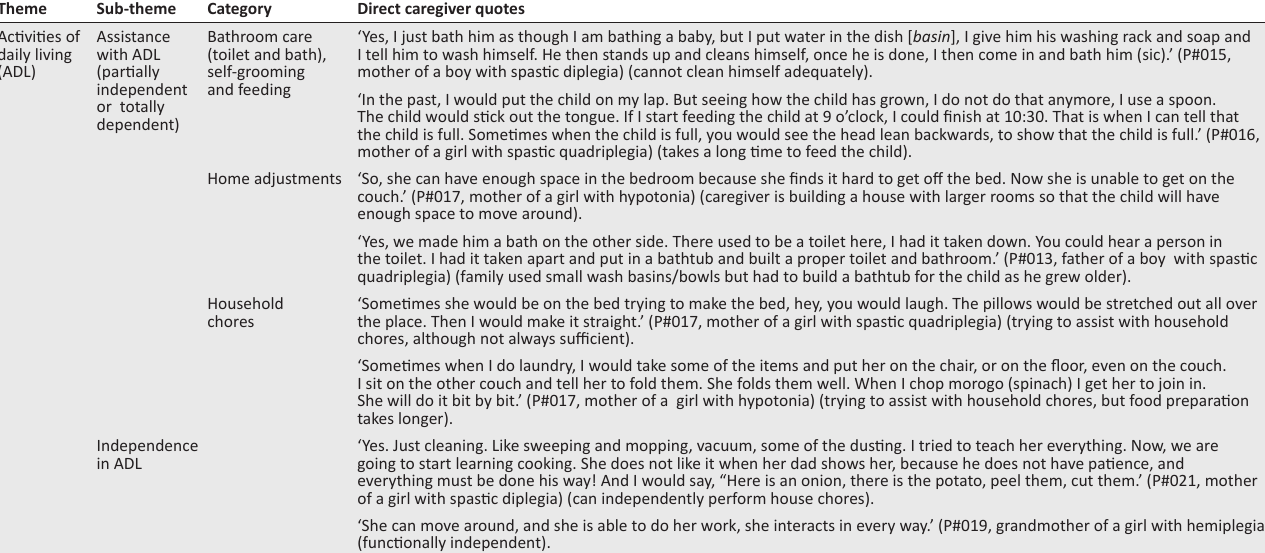
TABLE 3: Participation in activities of daily living based on interviews with caregivers.